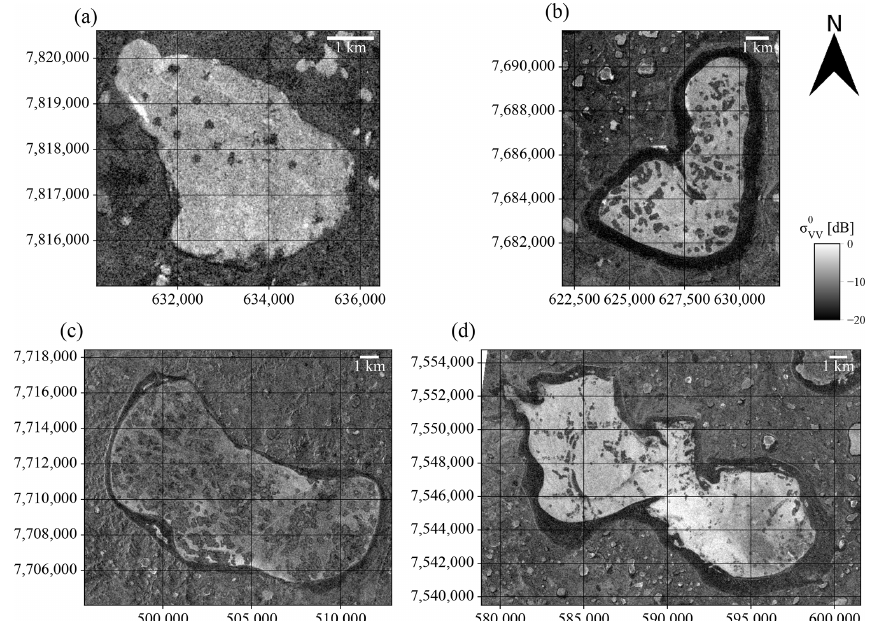
Figure 14. Examples of Sentinel-1 IW mode VV-polarised images of other lakes in Yamal with regions of anomalously low backscatter similar to those on Lake Neyto. (a) Lake Yanunto on 25 May 2019. (b) Lake Penadoto on 25 May 2017. (c) Lake Yambuto on 16 May 2018. (d) Lake Yarroto-2 on 3 May 2019. CRS: WGS 84 / UTM zone